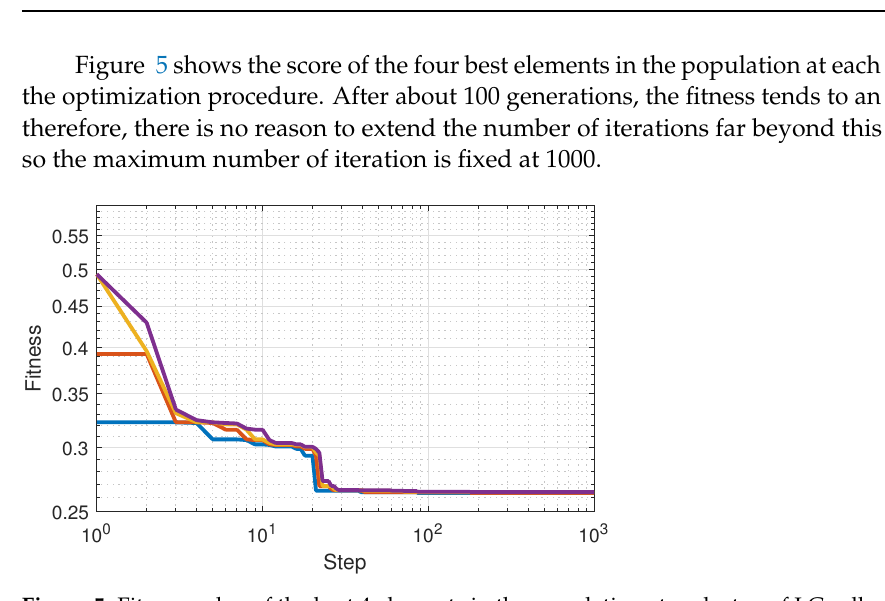
Figure 5. Fitness value of the best 4 elements in the population at each step of LG cell with cycle A. For demonstrating the algorithm power, all the possible combinations are